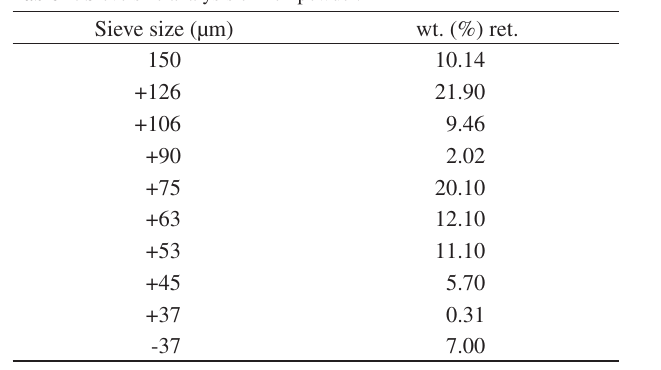
Table 2. Sieve size analysis of iron powder.